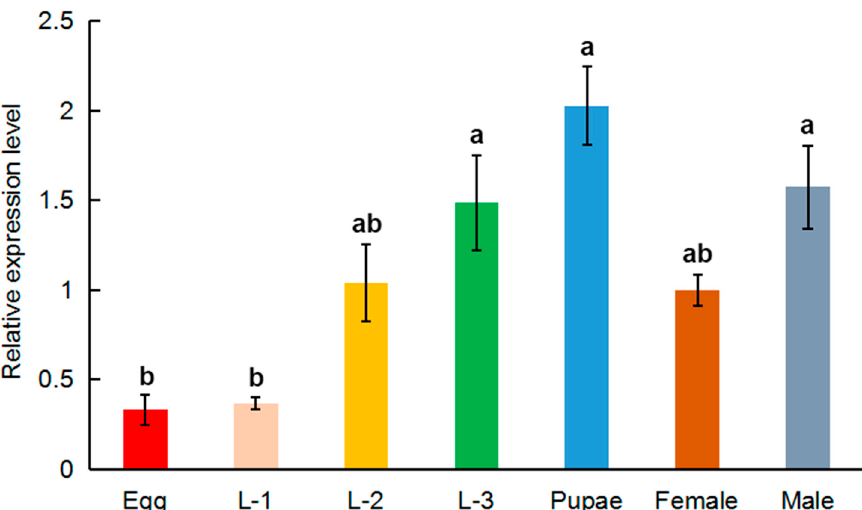
Figure 4. The expression profile of MRLC-sqh during various stages of O. communa development. The expression fold changes were related to the female. The transcript level of MRLC-sqh was normalized against that of RPL4 . Relative expression is represented as mean ± SE. L-1: 1st-instar larvae; L-2: 2nd-instar larvae; L-3: 3rd-instar larvae; Female: 3-day-old female adults; Male: 3-day-old male adults. Bars with different lowercase letters are significantly different at p < 0.05.